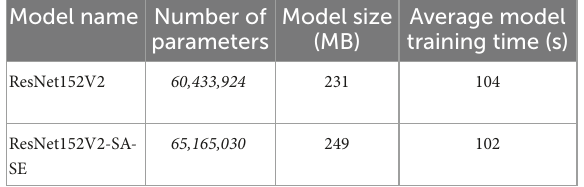
TABLE 4 Comparison of the two models.